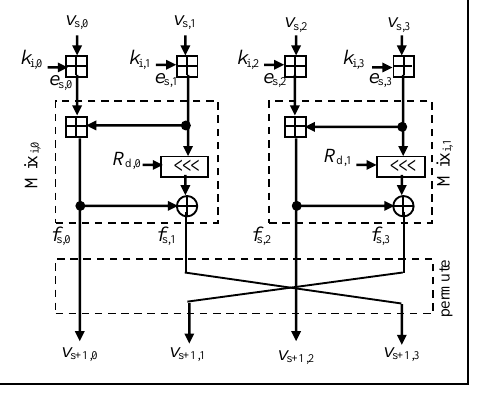
Figure 2. Single round of Threefish256 encryption [8] Table 1. R values in Threefish 256